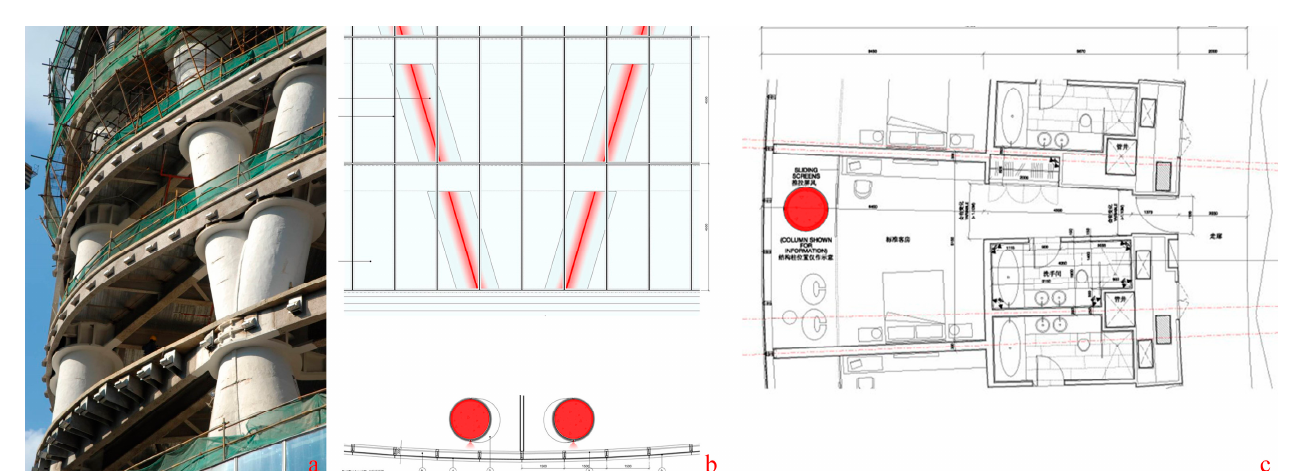
Figure 19. Diagram of the peripheral columns of Guangzhou International Financial Center. ( a ) Photos of construction site; ( b ) Schematic diagram of night light; ( c ) Location of structural